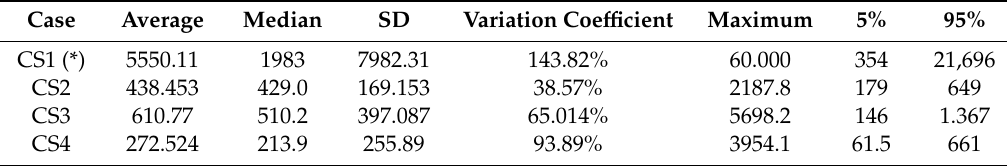
Table 11. Statistical data on the concentration of TVOCs (ppb) before lockdown.